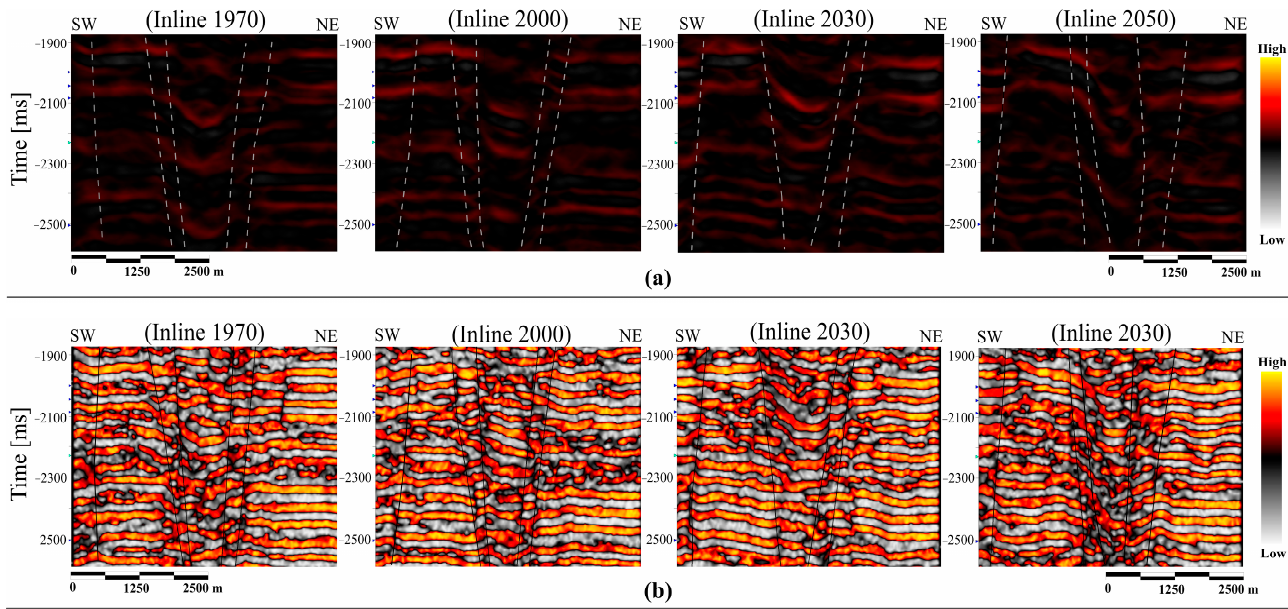
Figure 5. Fault system tracing and interpretation in the Kadanwari field using resemble brittle deformation features (seismic reflection discontinuities, terminations, and amount of displacement) on ( a ) dip magnitude and ( b ) seismic edge enhancement attributes cross-sections.